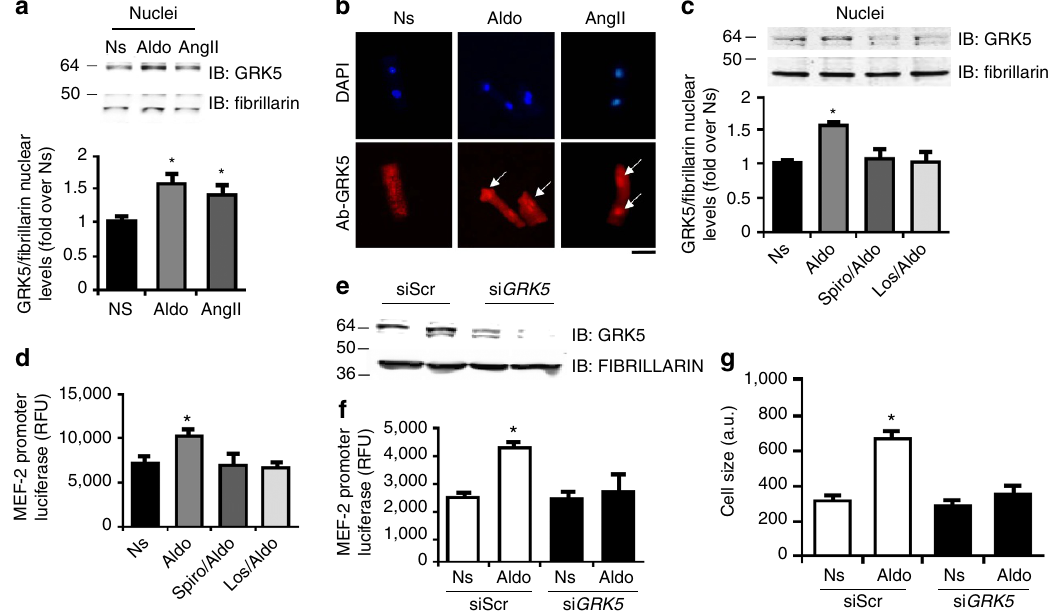
Figure 4 | Aldosterone-mediated GRK5 nuclear localization and hypertrophic response. ( a ) Representative immunoblots (upper panels) and densitometric analysis (lower panel) of multiple independent experiments ( n ¼ 3) to evaluate GRK5 levels in nuclear fractions purified from NRVMs, unstimulated (Ns) or stimulated with Aldo (1 m M) or AngII (1 m M) for 30min. Fibrillarin was used as loading control; * P o 0.05 versus Ns. ( b ) Representative panels of DAPI (upper) and GRK5 (bottom) immunofluorescence images in adult ventricular myocytes. The cells were Ns or stimulated with Aldo (1 m M) or AngII (1 m M) for 30min; scale bar, 10 m m. ( c ) Representative immunoblots (upper panels) and densitometric analysis (lower panel) of multiple independent experiments ( n ¼ 3) to evaluate GRK5 levels in nuclear fractions purified from NRVMs Ns or stimulated with Aldo (1 m M) for 30min. Before Aldo, a group of cells was pre-treated with Spiro (10 m M) or Los (10 m M) for 30min. Fibrillarin was used as loading control; * P o 0.05 versus Ns. ( d ) Bar graph showing MEF2 reporter activity in NRVMs measured using a luciferase assay system. Cells were infected with an Ad encoding for MEF2 promoter-luciferase (Ad-MEF2-Luc) reporter construct for 48h. Following the infection, the cells were Ns or stimulated for 24h with Aldo (1 m M). Before Aldo, a group of cells was pre-treated with Spiro (10 m M) or Los (10 m M) for 30min; * P o 0.05 versus Ns. ( e ) Representative immunoblots showing total GRK5 levels in NRVMs transfected with siRNAs targeting GRK5 (si GRK5 ). Scrambled siRNAs (siScr) were used as control. The cells were then Ns or stimulated for 24h with Aldo (1 m M). ( f ) Bar graph showing MEF2 reporter activity in NRVMs measured using a luciferase assay system. Cells were infected with an Ad-MEF2-Luc and transfected with siRNAs targeting GRK5 (si GRK5 ). siScr were used as control. The cells were then Ns or stimulated for 24h with Aldo (1 m M); * P o 0.05 versus siScr. ( g ) Cumulative fluorescence data from ( n ¼ 3) independent experiments of a -sarcomeric actinin staining in NRVMs ( B 200 cells analysed for the group for each experiment) transfected with siGRK5 or siScr. The cells were Ns or stimulated with Aldo (1 m M) for 48h; * P o 0.05 versus siScr Ns. ( a , c , d , f , g ) Statistical significance between groups was determined by one-way ANOVA with Bonferroni post hoc correction. All data are shown as mean ±